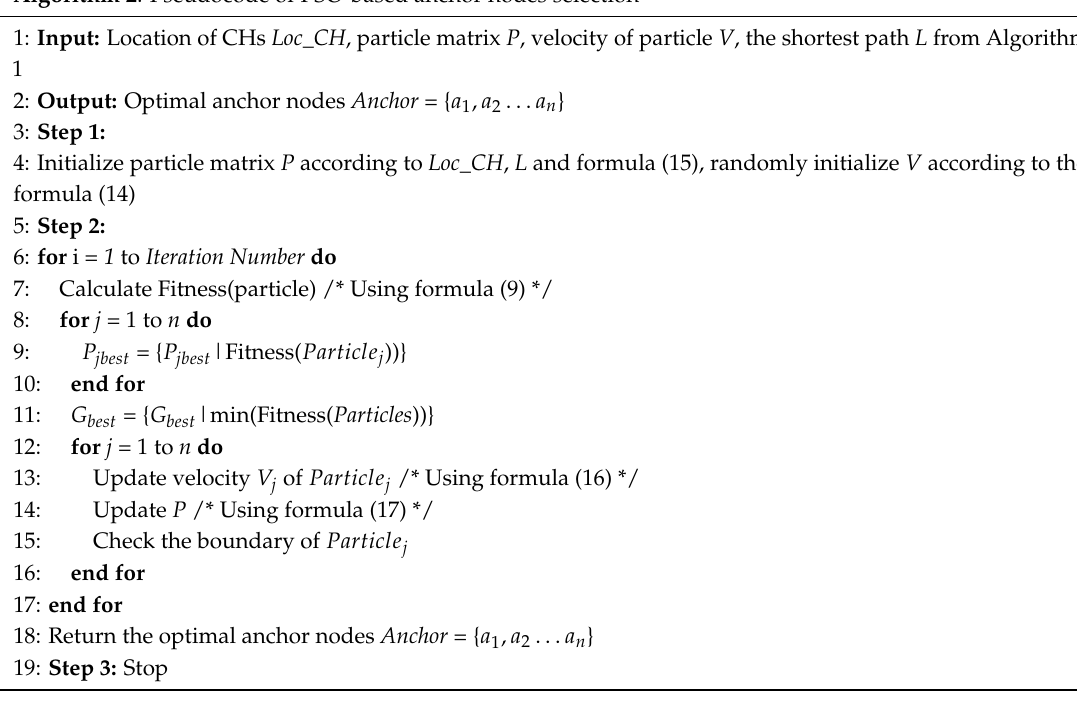
Algorithm 2 : Pseudocode of PSO-based anchor nodes